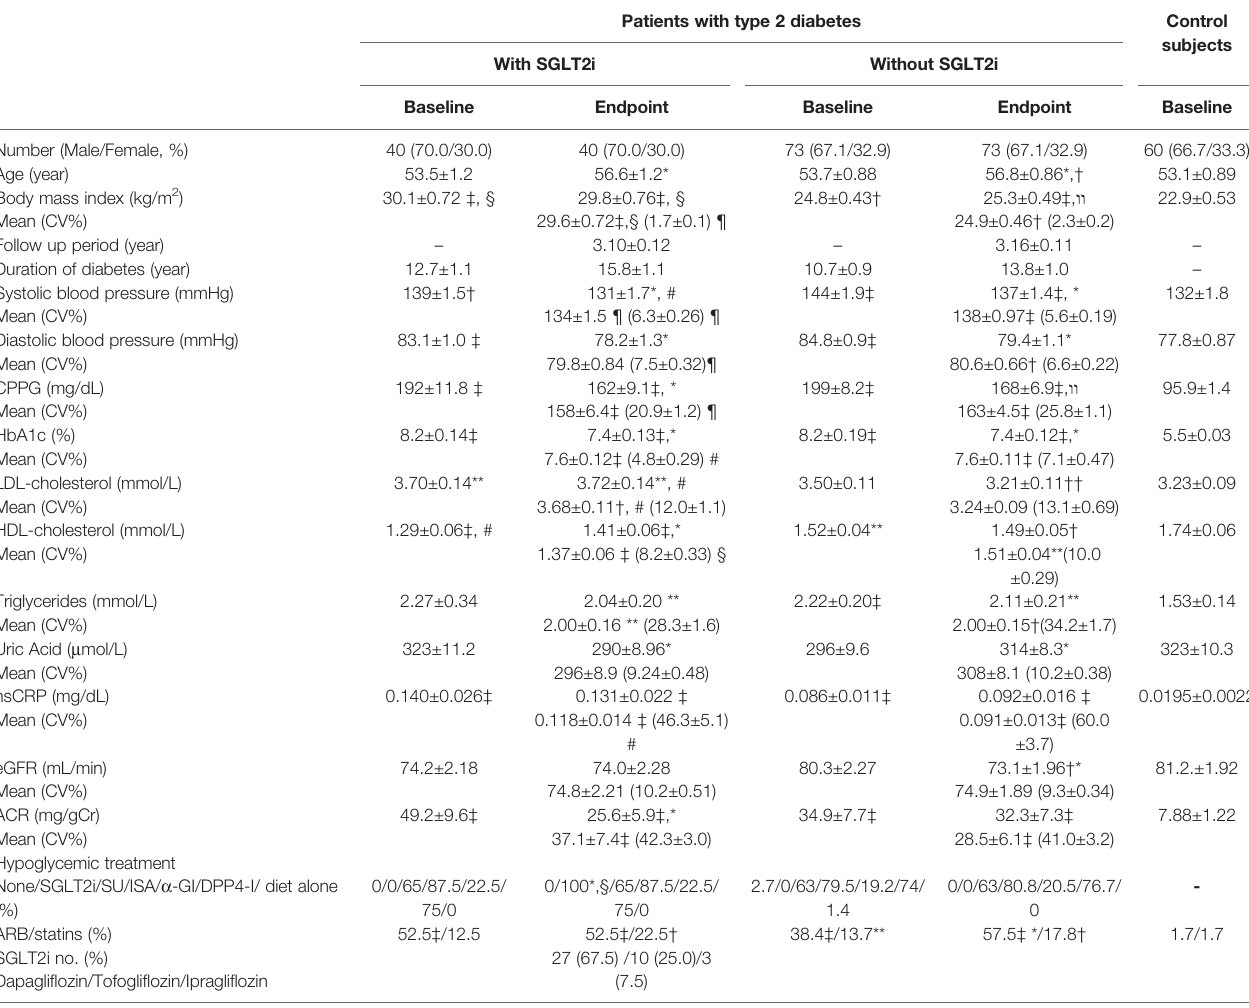
TABLE 1 | Demographic data, clinical characteristics, and prescription of drugs at the baseline and endpoint in patients with type 2 diabetes treated with or without sodium glucose cotransporter-2 inhibitor and at baseline in control subjects. Patients with type 2